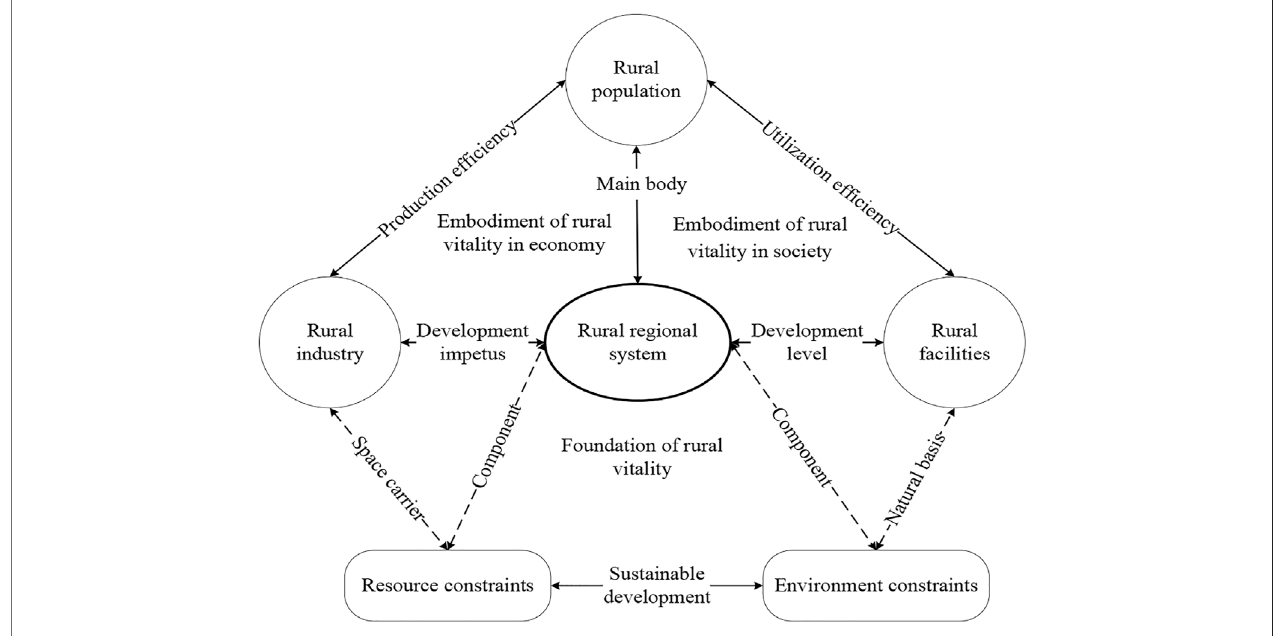
FIGURE 1 | Composition of rural